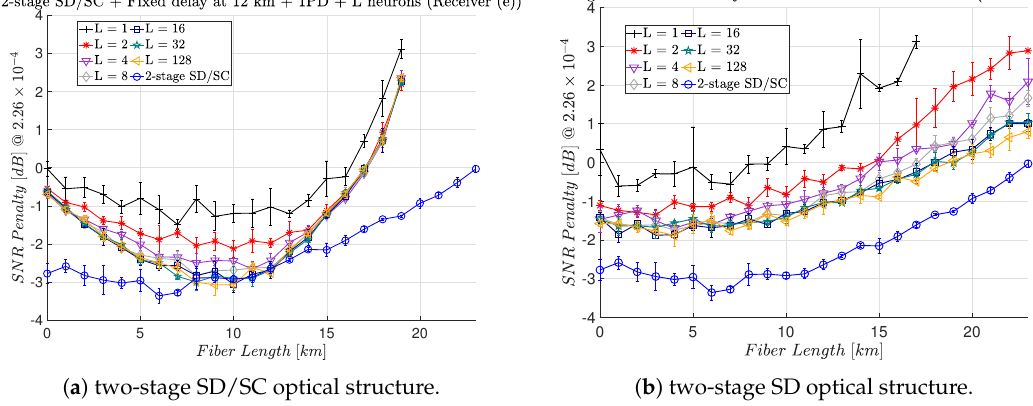
Figure 10. Analyzing number of neurons for the digital equalization in the hybrid